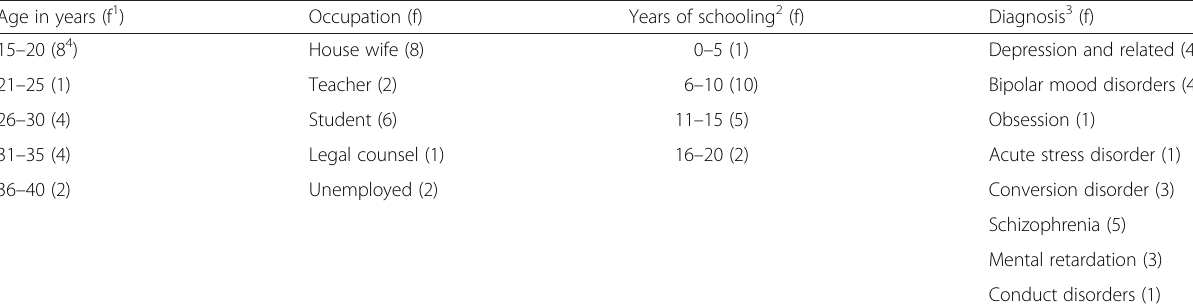
Table 1 Demographic and type of mental disorders of the patients of interviews Age in years (f 1